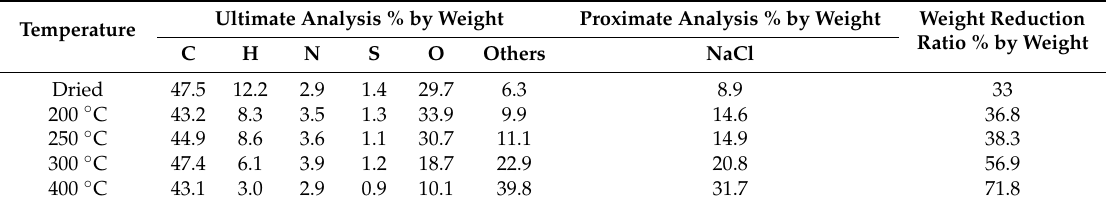
Table 2. Elementary Analysis of pyrolysis chars per